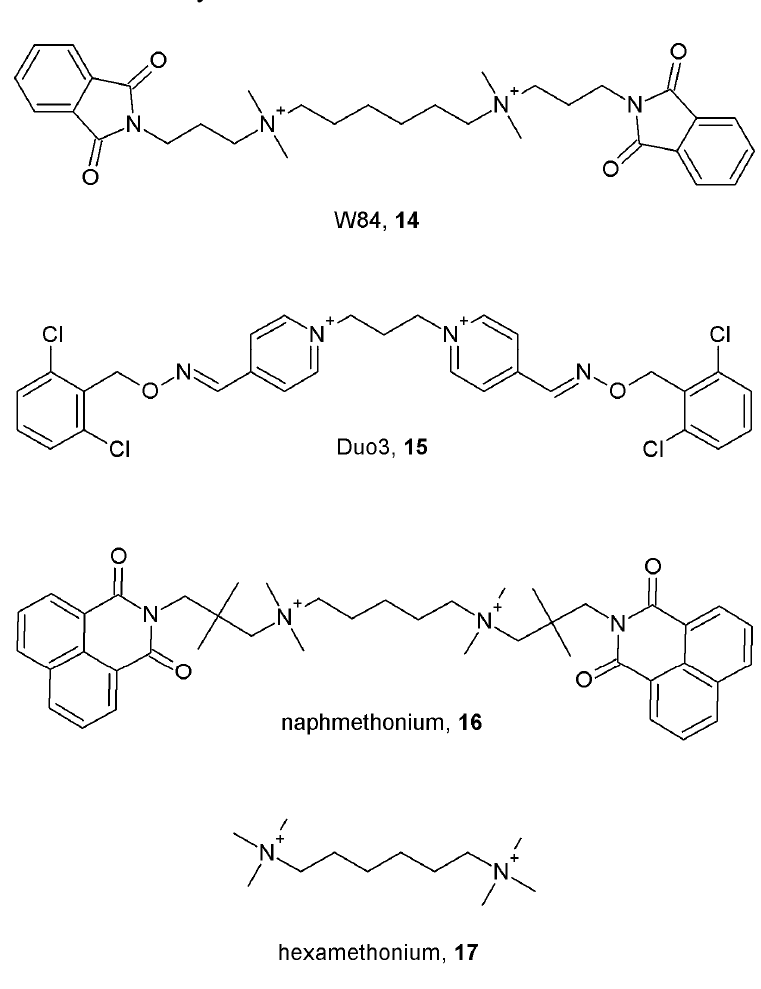
Figure 3. Structures of symmetric allosteric modulators of muscarinic